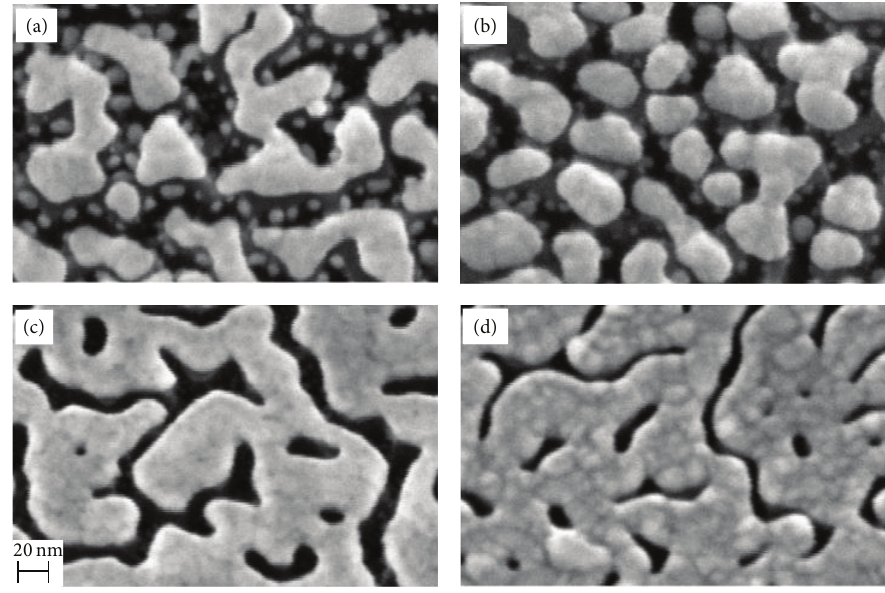
Figure 7: SEM images of an 8nm thick nanostructures made of Au (cases (a) and (c)), and Ag ((b) and (d)) without ((a) and (b)), and with ((c) and (d)) a sublayer of Ti. In (a) and (c), 𝛼 = 0. In (b) and (d), 𝛼 = 70 ∘ ; the samples were rotated during the deposition. The view angle is 30 ∘